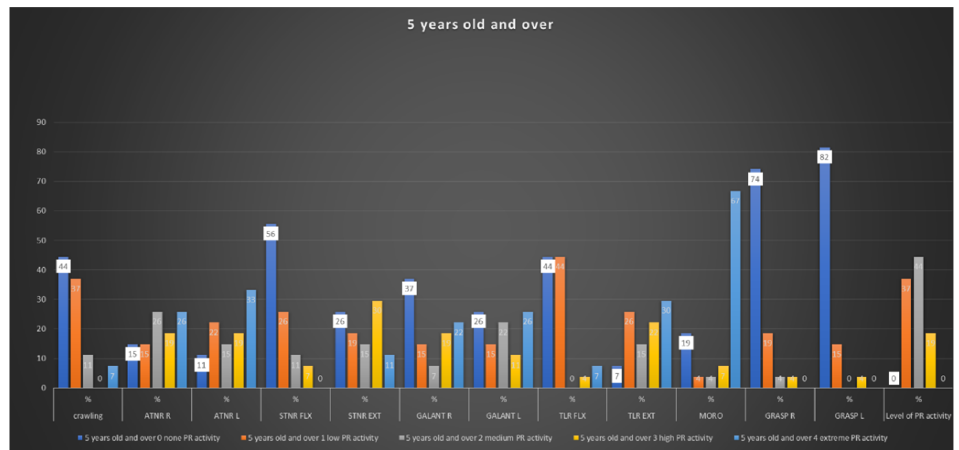
Figure 4. The scale of primitive reflexes (PRs) activity in older children. Percentage of crawling pat- tern performance and the reflexes activity.